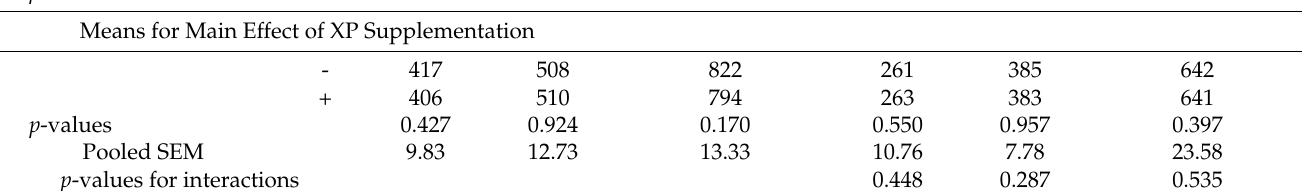
p -values for interactions